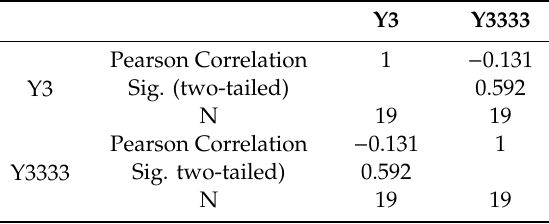
Figure 17. Household number and growth rates in ETAT areas and Niigata (1990–2018). Table 14. Correlations between Y3 and